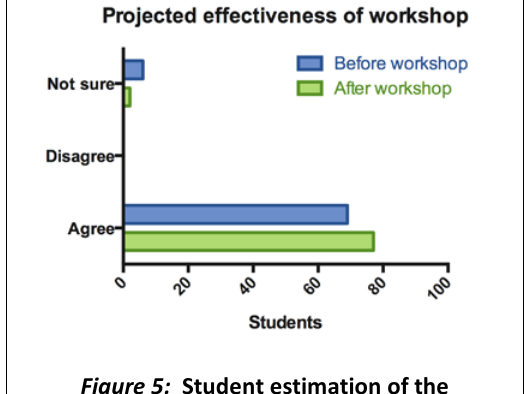
Figure 5: Student estimation of the effectiveness of the workshop in easing the transition into the first